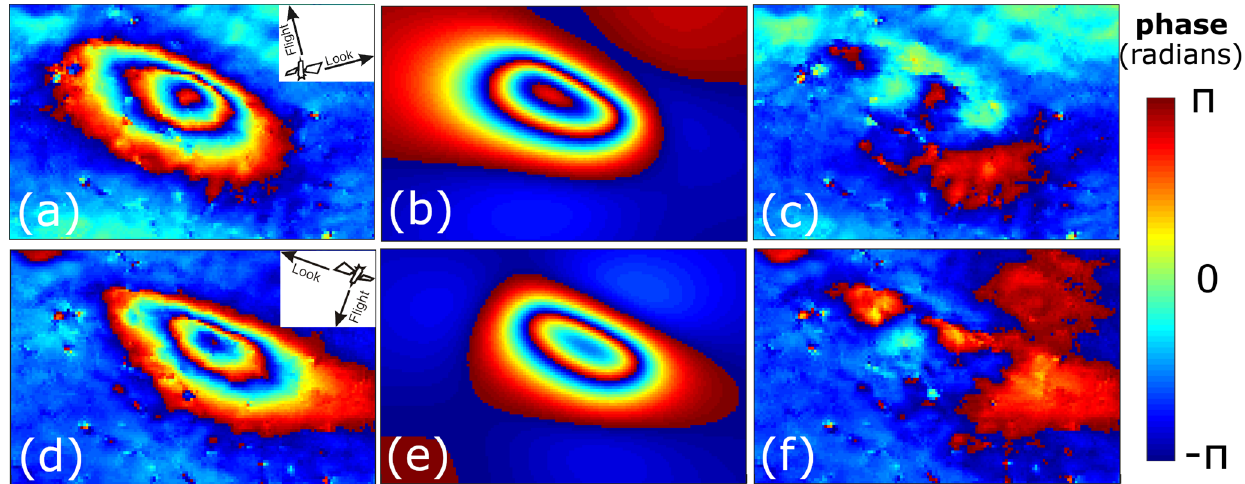
Figure 2. The interferograms used, along with their synthetic interferograms, calculated from the inferred model and the residuals: ( a ) The ascending interferogram of track 102 with ( b ) their corresponding modeled synthetic one and ( c ) the residuals, ( d ) the descending interferogram of track 7 and similar for ( e , f ).